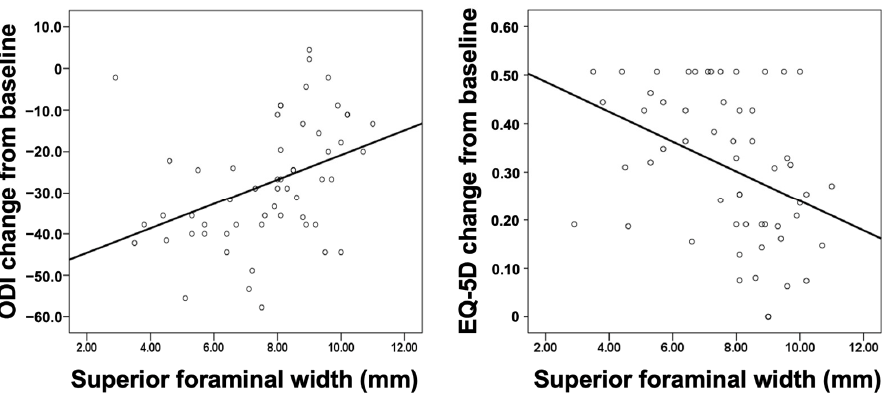
Figure 3. Scatter plot of the superior foraminal width against changes in the ODI (left panel) and EQ-5D (right panel) from baseline to the 1 year follow-up. EQ-5D, EuroQol-5D; ODI, Oswestry Disability Index.